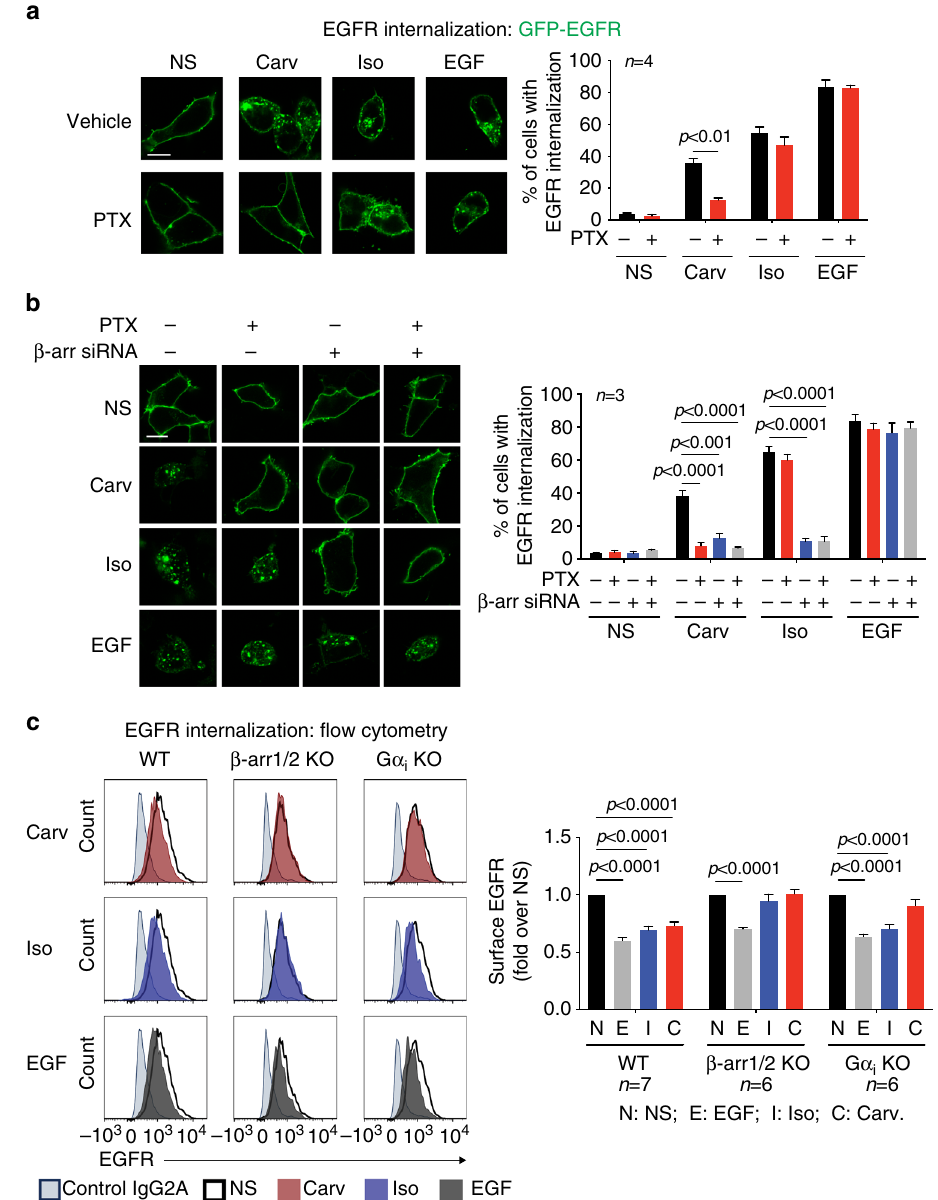
Fig. 5 Both G α i and β -arrestins are required for carvedilol-induced β 1 AR-mediated EGFR internalization. a The effect of PTX on ligand-stimulated EGFR internalization. β 1 AR stable cells with transient transfection of GFP-EGFR were pretreated with vehicle or 200 ng per ml PTX for 16 h. Then the cells were stimulated with 10 μ M carvedilol, 10 μ M isoproterenol or 10 ng per ml EGF for 5 min. Both carvedilol and isoproterenol promoted EGFR internalization, but only the carvedilol-induced response was PTX sensitive. Scale bar = 10 μ m. b Either PTX pretreatment or β -arrestins knockdown blocked carvedilol-induced EGFR internalization. β 1 AR stable cells were transfected with GFP-EGFR together with scrambled control siRNA or β -arrestin1/2 siRNA. 48 h after transfection, cells were pretreated with vehicle or 200 ng per ml PTX for 16 h before stimulation. Scale bar = 10 μ m. c Carvedilol-induced EGFR internalization was abrogated in β -arrestins or G α i knockout cells. Wild type, β -arrestin1/2 knockout or G α i knockout cells were transfected with CFP- tagged β 1 ARs. Cells were stimulated with 10 μ M carvedilol, 10 μ M isoproterenol or 10 ng per ml EGF for 5 min. The EGFR level on cell surface was assessed by fl ow cytometry. Both carvedilol- and isoproterenol-induced EGFR internalization were impaired in the β -arrestin knockout cells, whereas only the carvedilol-induced response was blocked in the G α i knockout cells. Data represent the mean ± SEM for n independent experiments as marked on the fi gure. Statistical signi fi cance was assessed using two-tailed paired Student ’ s t -test ( a ) or one-way ANOVA with Bonferroni correction ( b , c (2) the af fi nity of the β 1 AR – β -arrestin interaction is low. Both the cytoplasmic tail ( β 2 AR-V 2 R) to increase the af fi nity of β -arrestin β β to the ligand occupied receptor 21 . However, as we have shown 1 AR and the 2 AR are known as class A receptors, since they are characterized by transient and weak interaction with β -arrestins (Fig. 8c), the C-tail of the β 1 AR is required for G α i recruitment. along with a rapid recycling to the plasma membrane after Therefore substituting the β 1 AR C-tail with the V 2 R tail would not provide a chimeric receptor suitable to study the role of G α i internalization. To demonstrate carvedilol triggered β -arrestin recruitment to the β 2 AR, previous studies used a chimeric in carvedilol stimulated β -arrestin recruitment. Importantly, we receptor consisting of the β 2 AR fused to vasopressin V 2 receptor cannot exclude that the carvedilol-stimulated β 1 AR signaling is